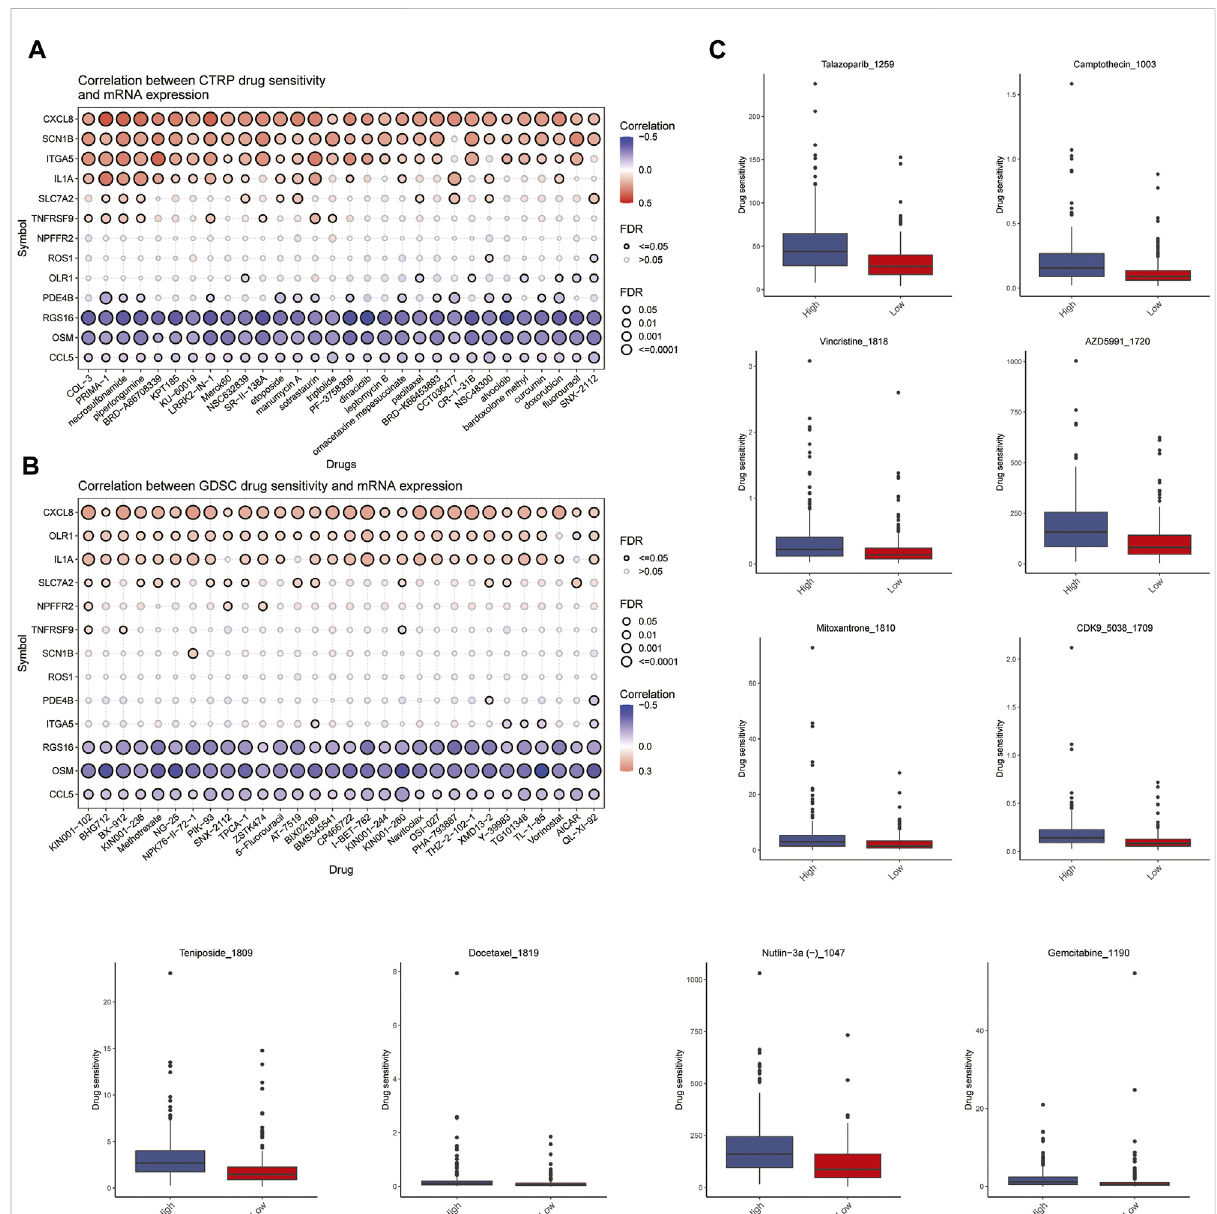
FIGURE 8 Analysis of drug sensitivity. (A,B) Relationship between Spearman correlation analysis (GSDC and CTRP) of 13 predicted model genes for drug sensitivity. (C) Differences in drug sensitivity between high and low risk groups of